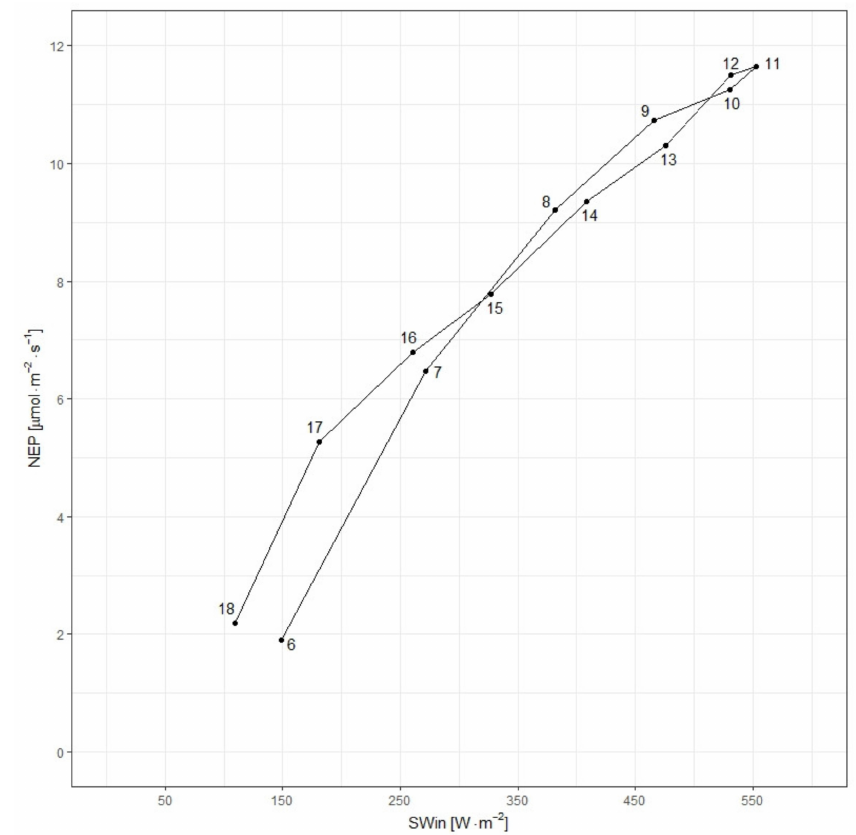
Figure 4. Mean diurnal pattern of the net ecosystem production (NEP) vs. total radiation flux density (SWin), during the period from 13 June to 18 September 2016. The mean hours of day (UTC + 1) are